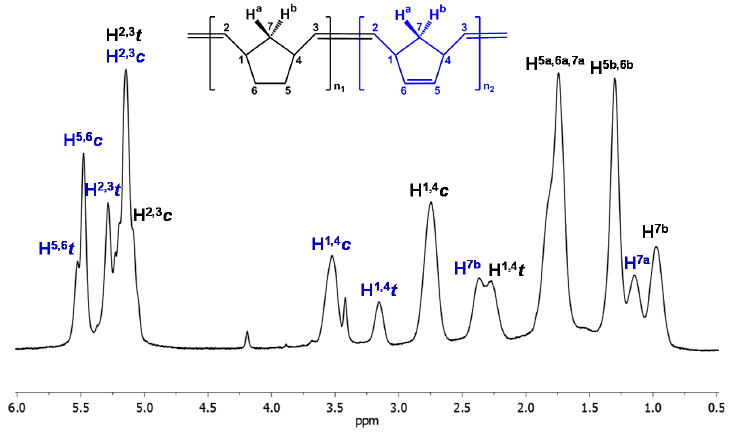
Figure 1. 1 H-NMR spectrum of linear PNBE/PNBD 400/100 copolymer.